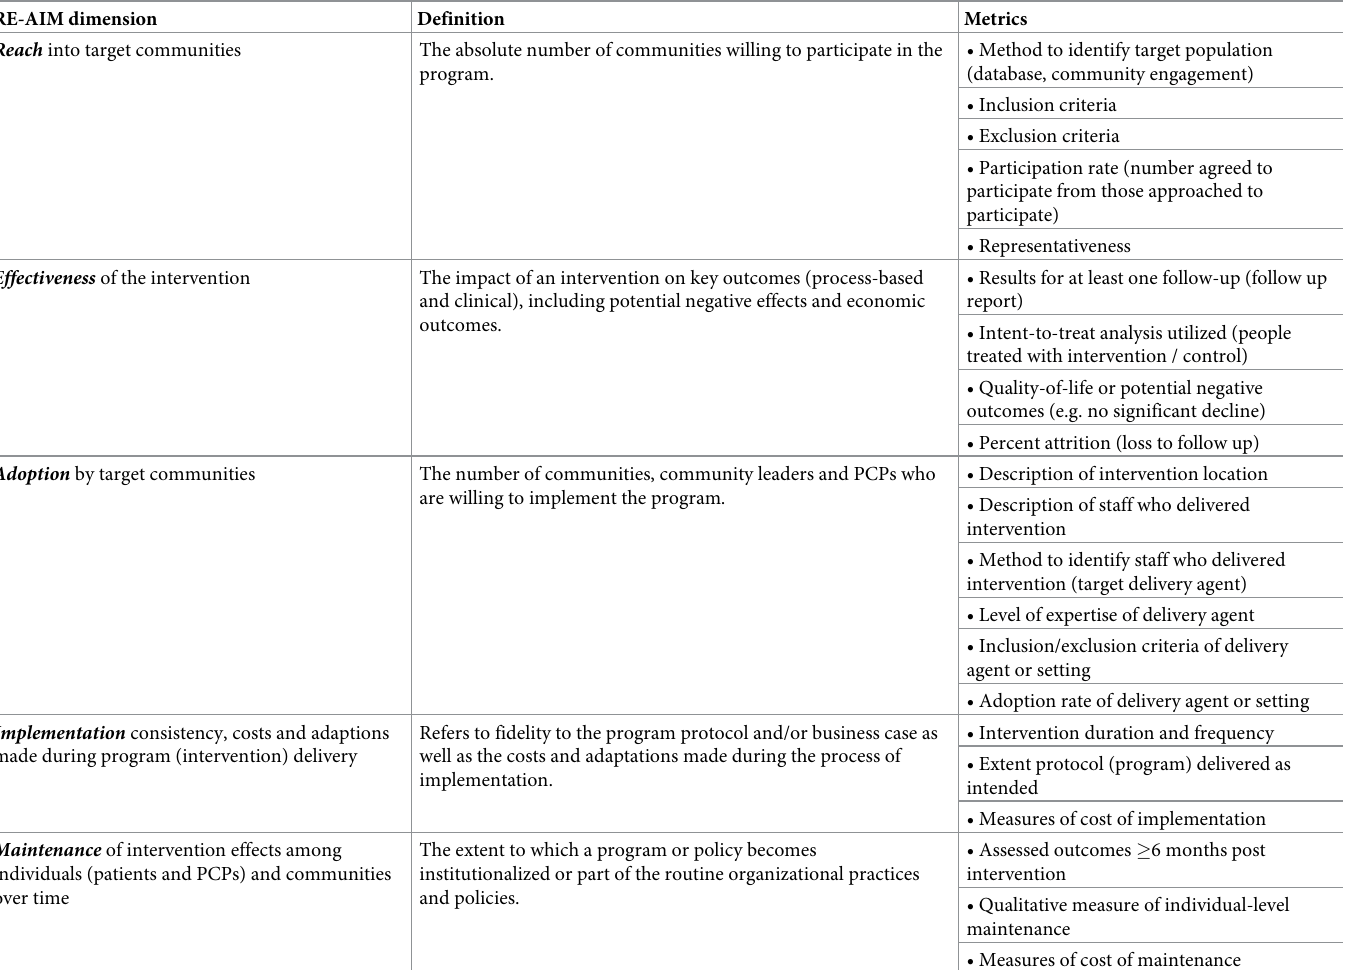
Table 3. Measures to capture internal and external fidelity of community-based interventions to reduce cardiovascular and kidney disease from non-pharmacologi- cal interventions in Indigenous populations. RE-AIM